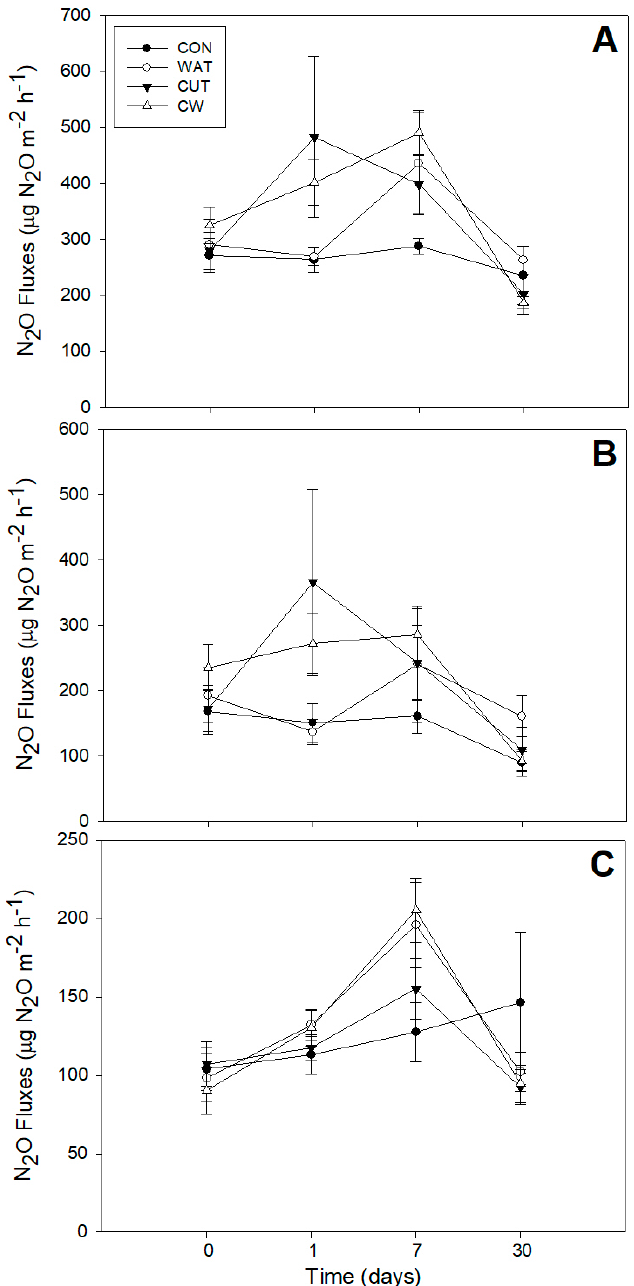
Figure 3A). Leaf removal treatments led to higher emissions, and CUT had its highest emissions one day after leaf removal (482.5 ± 143.55 µg N 2 O m − 2 h − 1 ; 95% CI = 380.4, 596.7) and CW at one week after the treatment was applied (489.8 ± 41.03 µg N 2 O m − 2 h − 1 ; 95% CI = 384.4, 595.5; Figure 3A). Plant-mediated N 2 O emissions followed the same pattern (Figure 3B) described for total emissions (Figure 3A). On the other hand, we found differences between the treatments for soil N 2 O emissions (F (9,132) = 2.52; p = 0.011; Figure 3C), and at seven days, CW showed higher soil N 2 O emissions (95% CI = 7.19, 148.4) than CON.